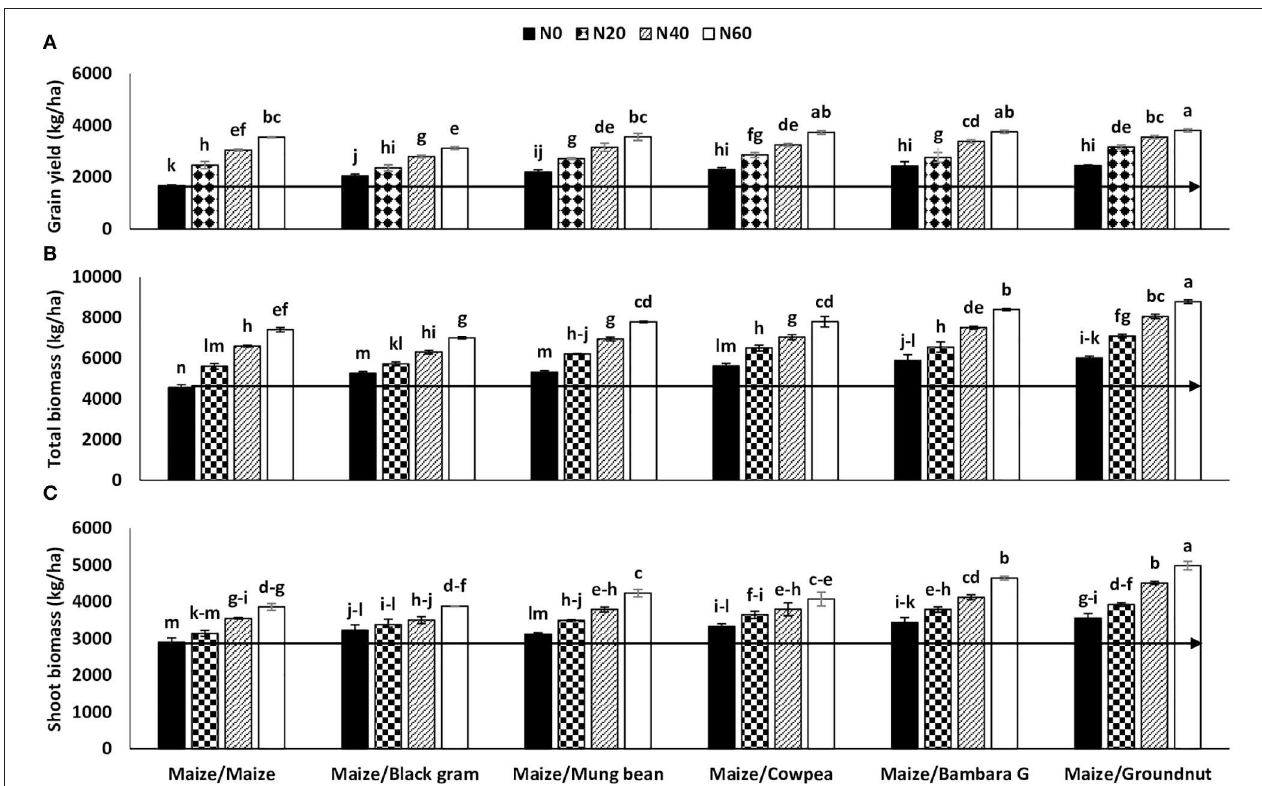
FIGURE 2 | Interactive effect of preceding crop and N fertilizer level on (A) grain yield, (B) total biomass, and (C) shoot biomass of maize planted in rotation at Nelspruit, Mpumalanga Province during the 2012/2013 cropping season. The horizontal line delineates increases in yield caused by N20, N40, and N60 relative to N0.